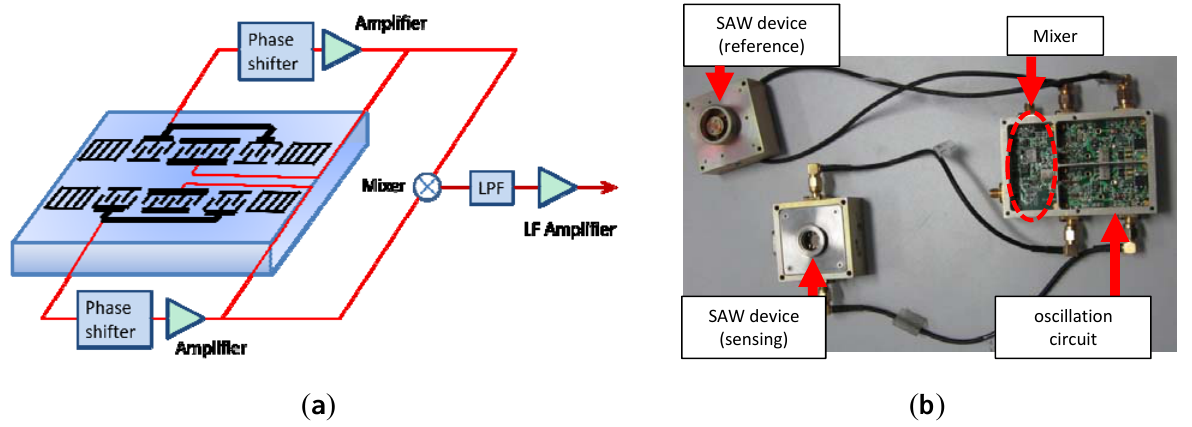
Figure 6. ( a ) Schematic and principle of the SAW oscillator, ( b ) the PCB with the SAW sensor.